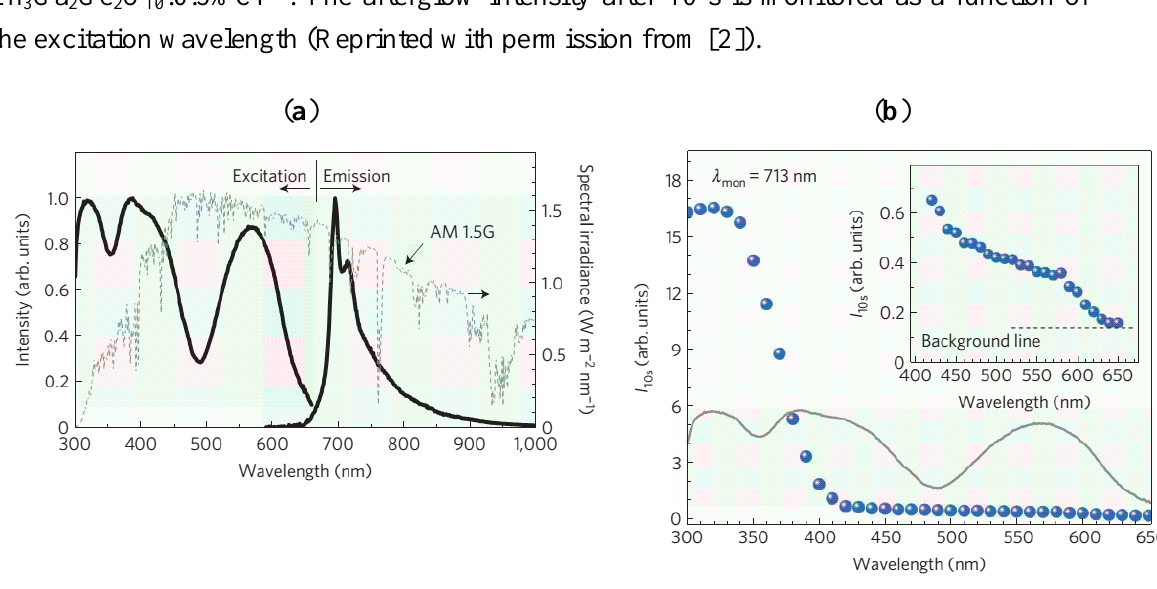
Ga Ge O :0.5%Cr 3+ ; 3 2 2 10